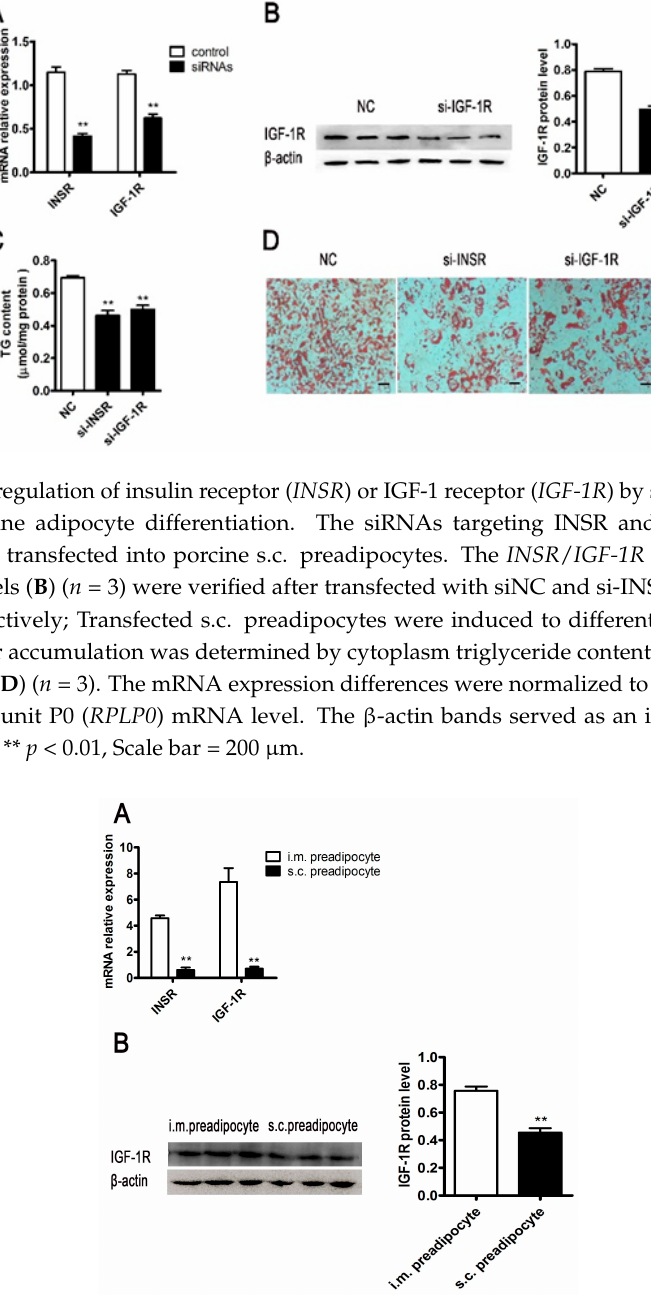
Figure 3. INSR and IGF-1R expression pattern in i.m. and s.c. preadipocytes. The comparison of INSR and IGF-1R mRNA expression levels in i.m. and s.c. preadipocytes ( A ) ( n = 3); The protein expression level of IGF-1R in i.m. and s.c. preadipocytes was detected by Western blot and subsequently quantified. ( B ) ( n = 3). The mRNA expression differences were normalized to RPLP0 mRNA level. The β -actin bands served as an internal control for protein loading. ** p < 0.01.